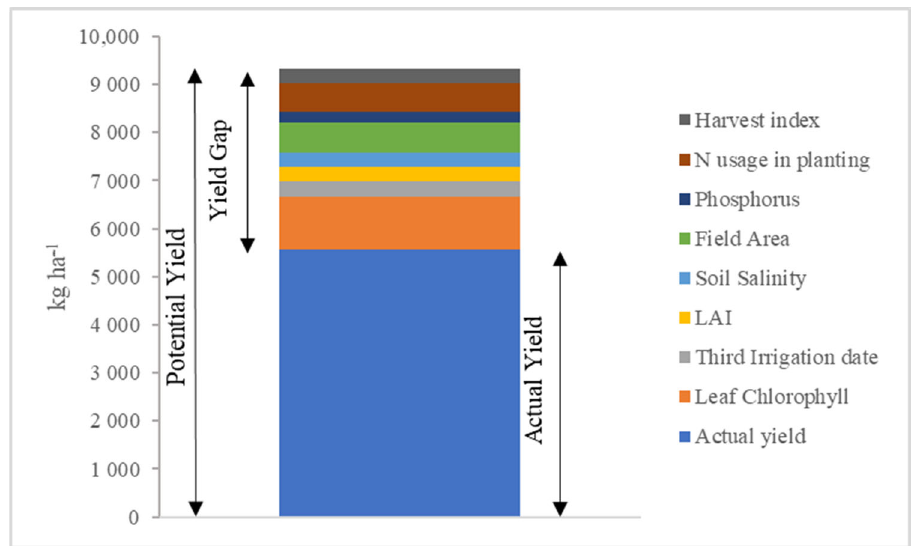
Figure 5. The extent of the major yield gap limiting factors.